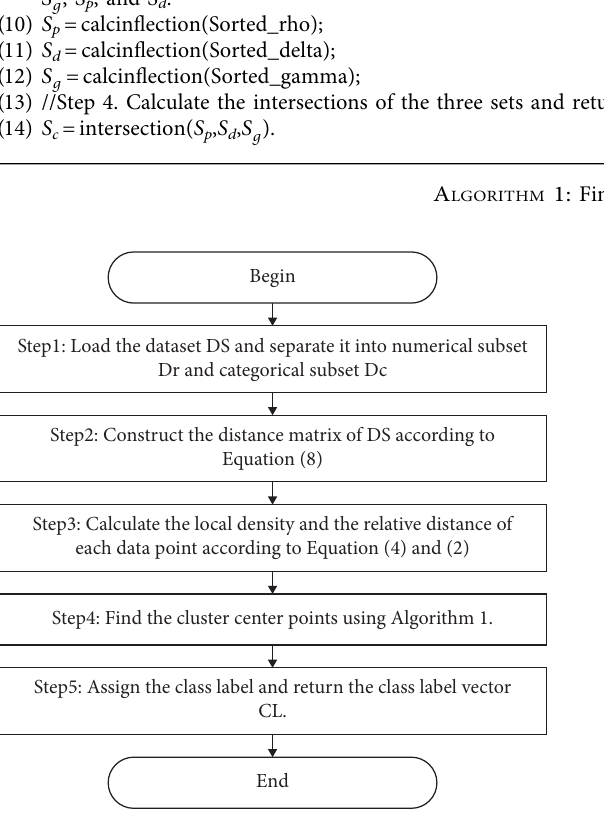
Figure 2: The flow chart of the AMDPC